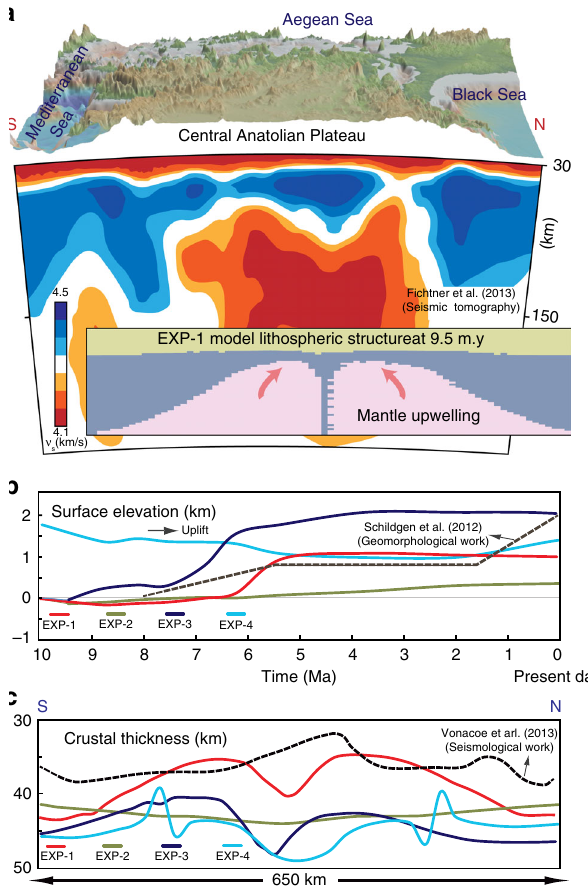
Fig. 4 Reconciling model results against the tectonics of Central Anatolia. a Present day surface topography at Central Anatolia and simpli fi ed S wave tomography model along 33° E 18 . The tomography model is reconciled with EXP-1 lithospheric structure model prediction at 9.5 My (forward model time, corresponds to approximately present). b Time series of the modeled surface elevation for EXP-1, EXP-2, EXP-3, and EXP-4 at x = 850 (on the margin of the instability), comparing with: (1) estimated uplift in the Taurides) 15 (southern margin of the plateau). c Crustal thickness variation along the arc root removal zone for models EXP-1, EXP-2, EXP-3, and